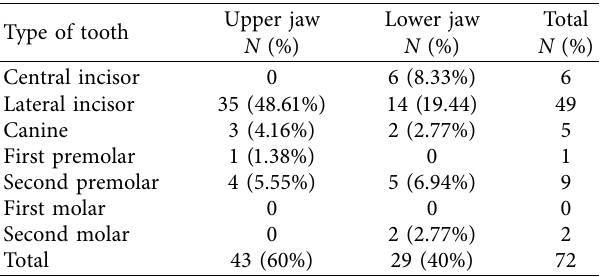
Table 1: Distribution of missing teeth according to the type of tooth and its location.